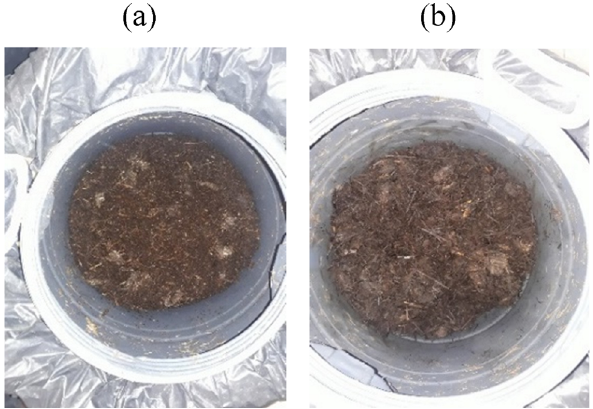
Figure 3: Composts ( a ) grape stalk + grass + straw; ( b ) elderberry stalk + grass +